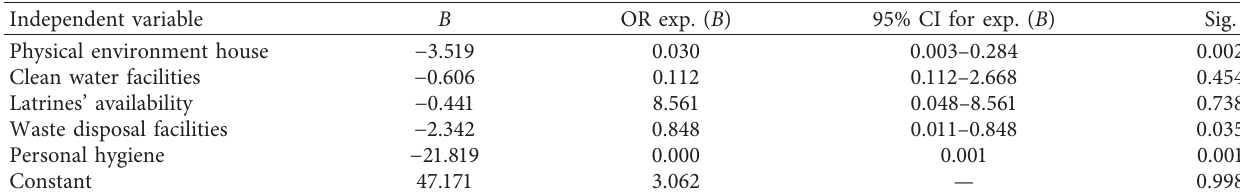
Table 3: Logistic regression